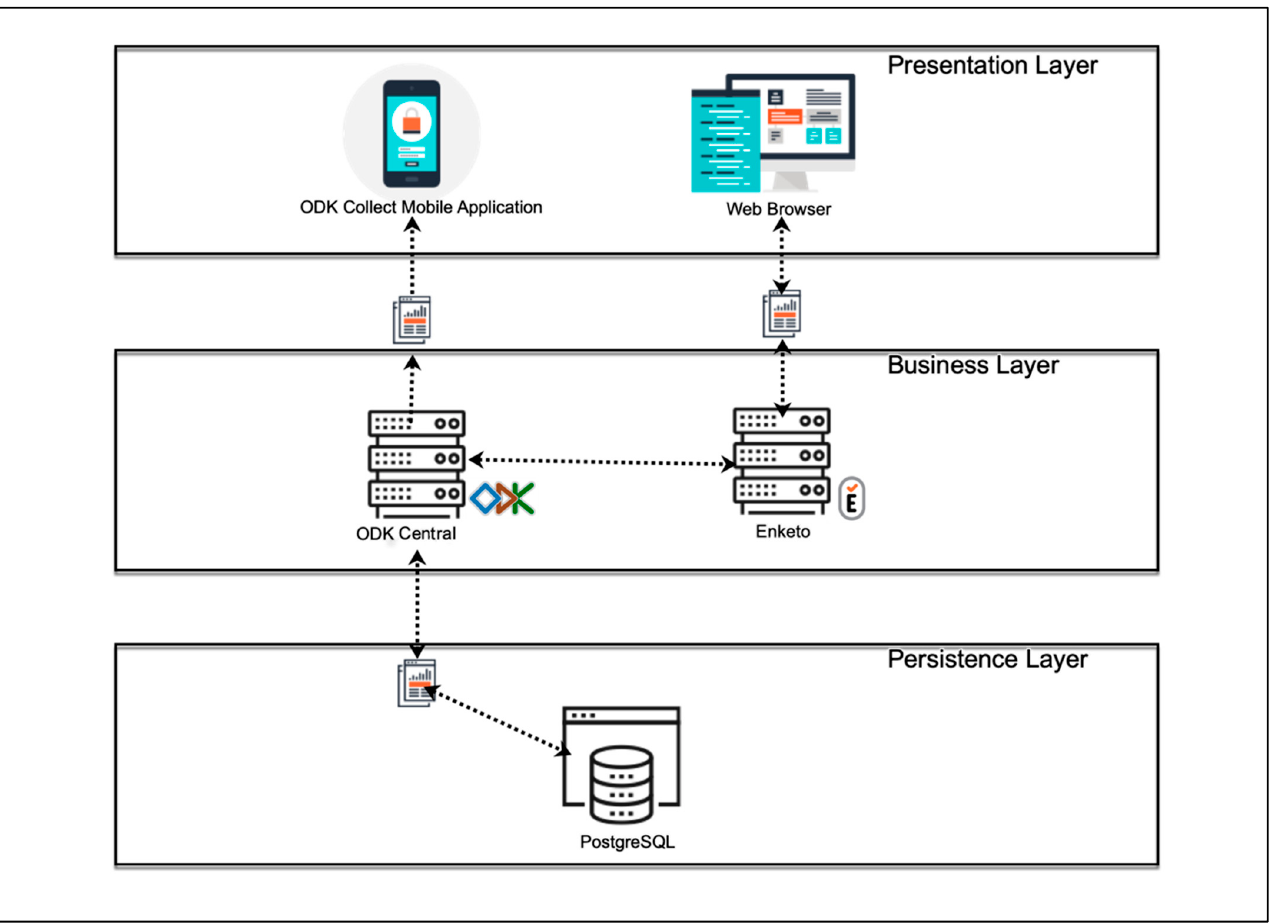
Figure 2. Software architecture of the developed application EULAT eCollect for electronic retrieval of patient and sample data in Latin American regions with a high incidence of GBC (Bolivia, Chile, north-western Argentina, and southern Peru).